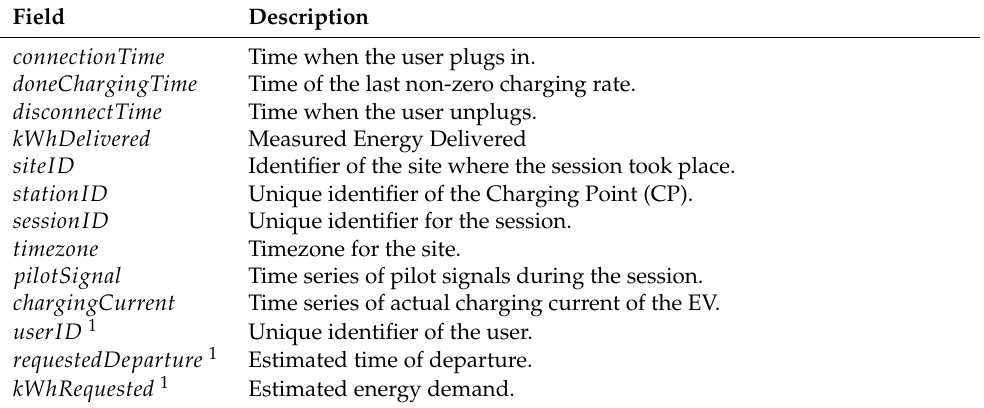
Table 1. ACN recorded data fields